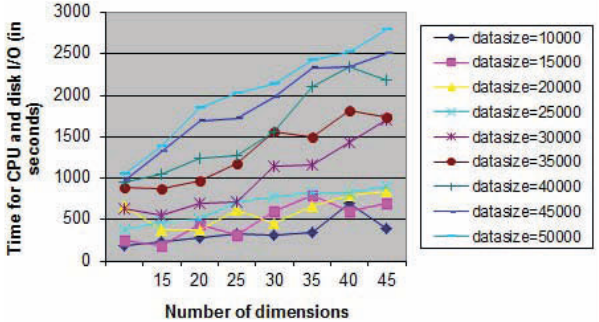
Figure 1. Running time on data sets with increasing dimensions.